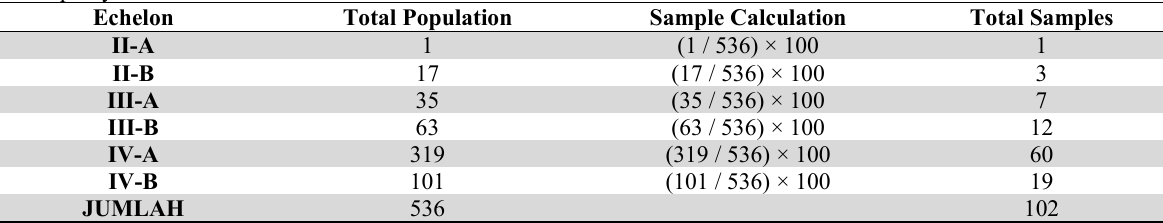
The number of respondents is based on employee strata in the Regional Government Organization (OPD) of Pare-Pare